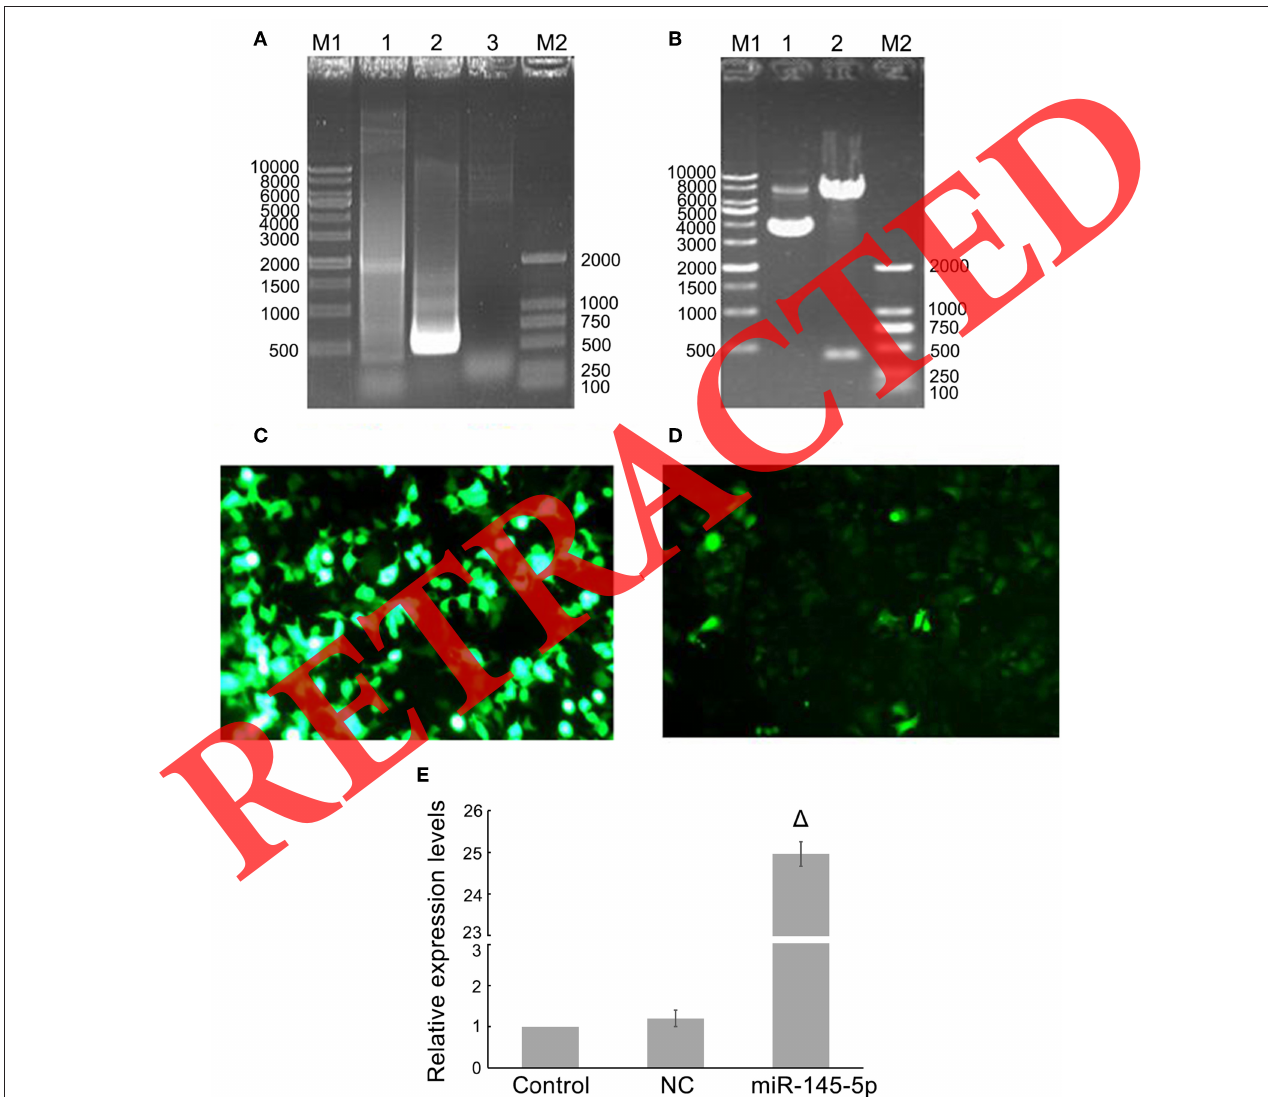
FIGURE 1 | Establishment of a miR-145-5p-overexpressing LNCaP cell line. (A) PCR amplification of miR-145-5p. M1: 1kb DNA marker; 1: negative PCR amplification; 2: miR-145-5p PCR amplification product (466 bp); 3: negative PCR amplification; M2: DL2000 DNA marker. (B) The miR-145-5p PCR product was ligated into the lentiviral vector and identified by double digestion. M1: 10kb DNA marker; 1: undigested plasmids; 2: Plasmids were digested by double enzymes; M2: DL 2000 DNA marker. (C) 293T cell line stably transfected with the virus. (D) LNCaP cell line stably transfected with negative control for miR-145-5p (7). (E) Detection of the relative expression of miR-145-5p by qRT-PCR; 1 P < 0.05 vs. the control and NC groups.